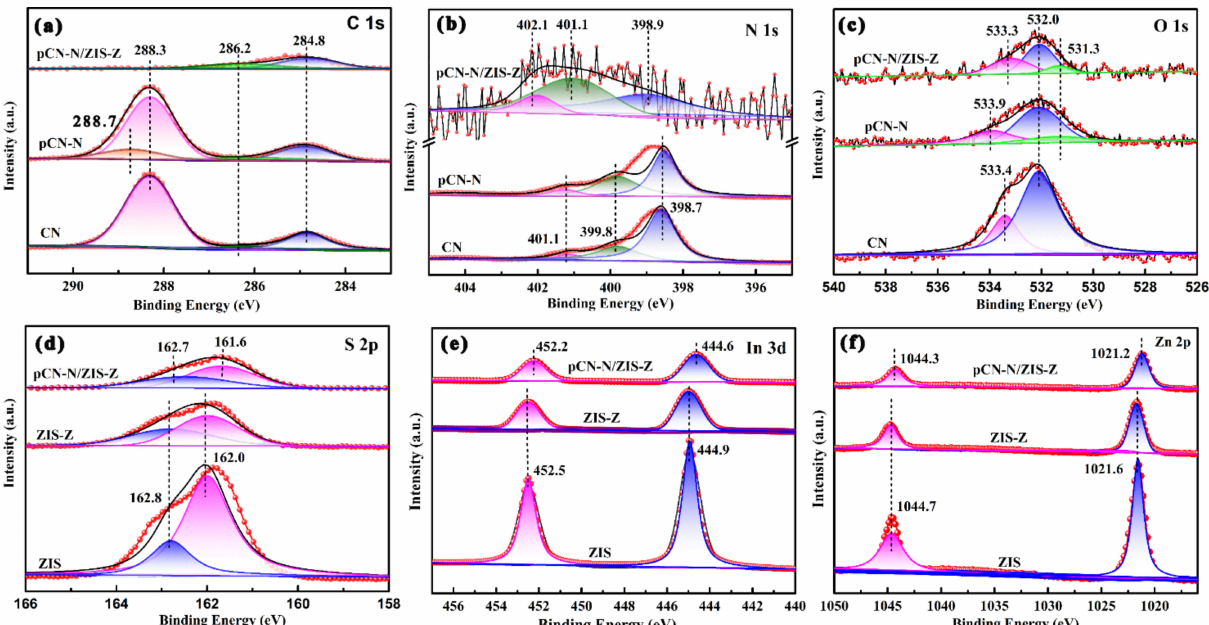
Figure 5. XPS spectroscopy spectra of CN, pCN-N, ZIS-Z, pCN-N/ZIS-Z nanocomposite. C 1s ( a ), N 1s ( b ), O 1s ( c ), S 2p ( d ), In 3d ( e ), and Zn 2p ( f